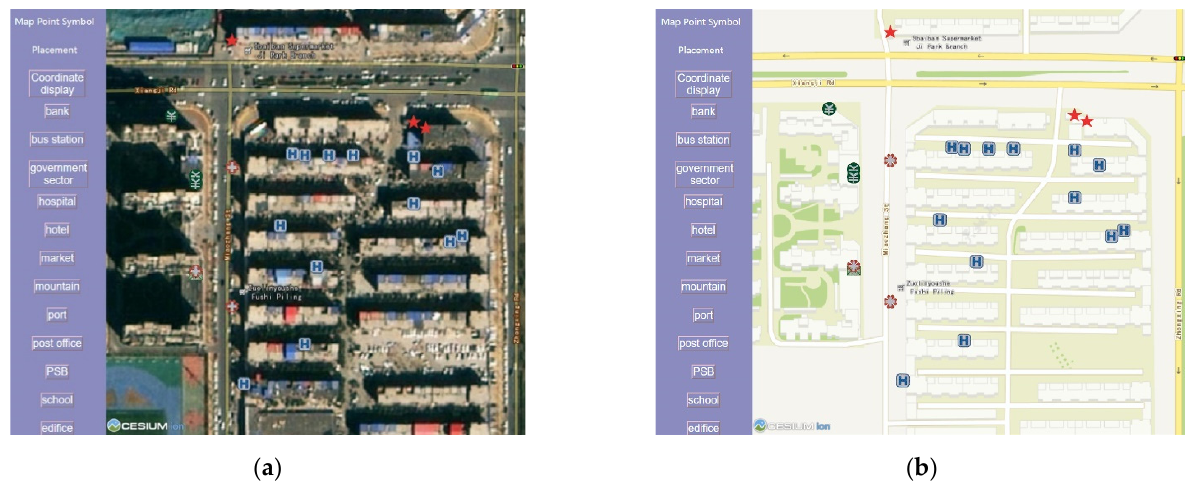
Figure 8. The rendering of the point symbols configuration on the Map World image and vector base map: ( a ) The configuration effect of the Map World image map; ( b ) The configuration effect of the Map World vector map.